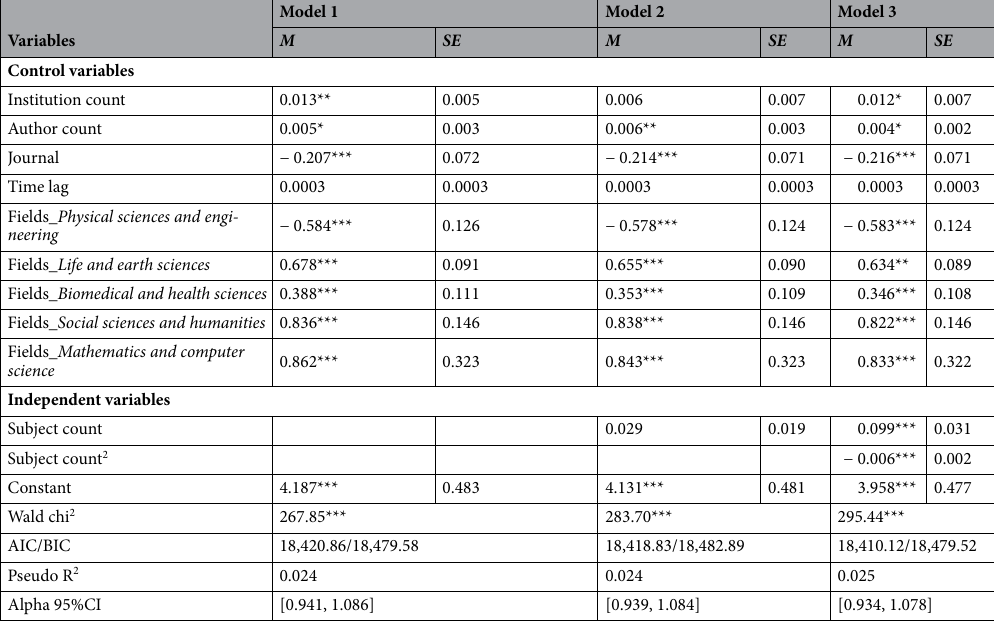
Table 2. Regression analysis results. *** p < 0.01, ** p < 0.05, * p < 0.1; Number of observations = 1539.